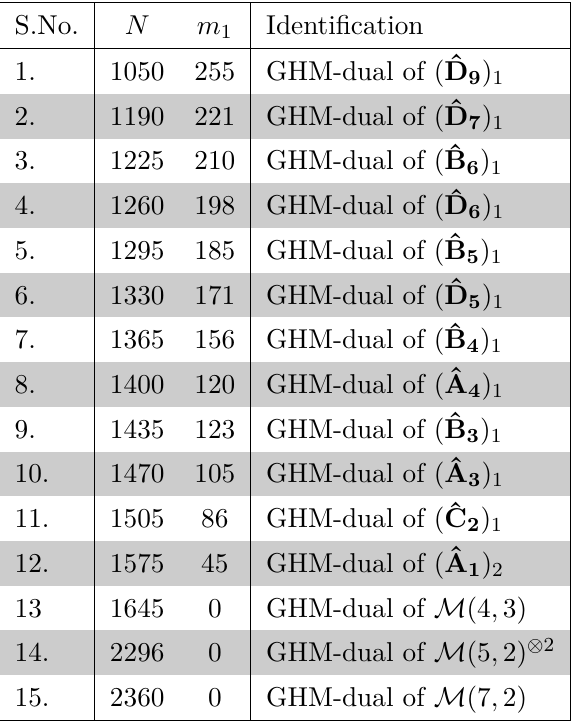
Table 8 . Category IV